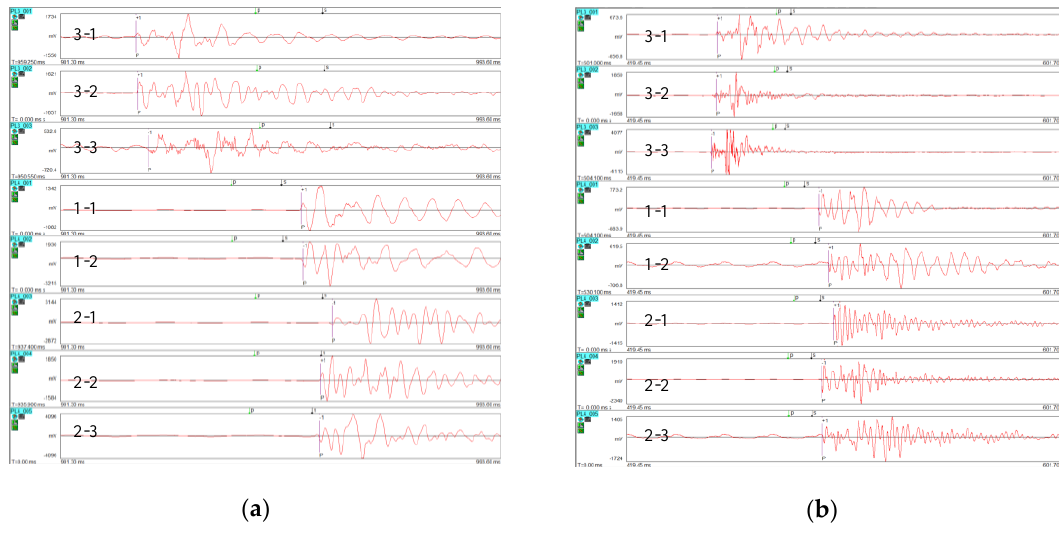
Figure 12. Arrival times of microseismic events as indicated by the array of sensors: ( a ) arrival time of an event in the right tunnel, the arrival time of Section 1 was earlier than that of Section 2, and Section 3 in the left tunnel had the earliest arrival time due to the complexity of the properties of the surrounding rock and the cavity; ( b ) arrival time of an event in the left tunnel. The arrival time of Section 3 was the earliest, and the arrival time at the positive side with three sensors (i.e., 1-1, 2-2, and 2-3), was earlier than that at the dorsal side with two sensors (i.e., 1-2 and